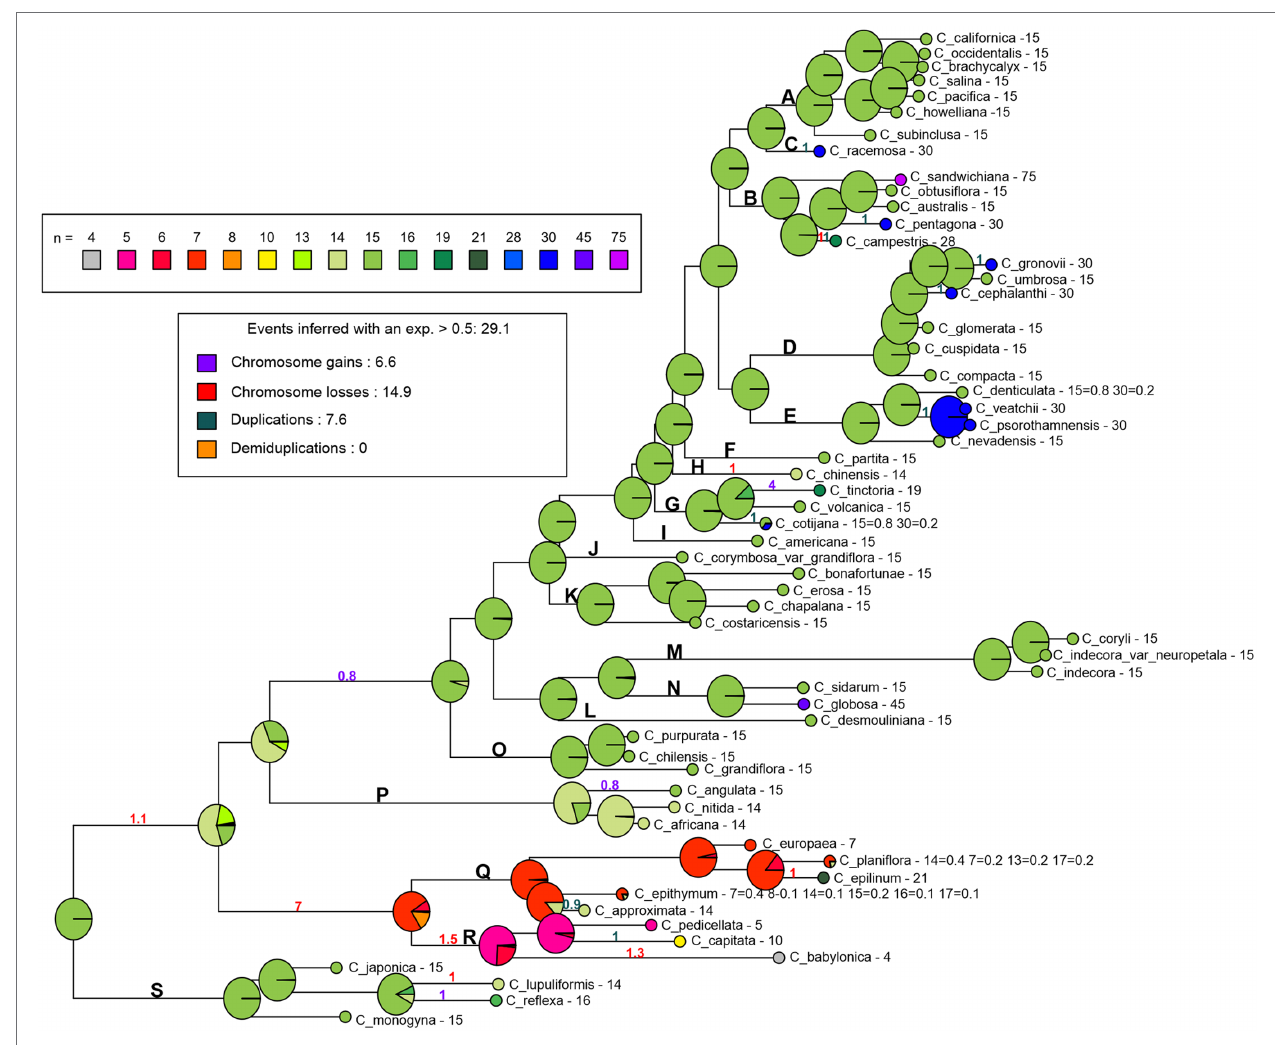
FIGURE 4 | Reconstruction of the chromosome number evolution in Cuscuta with the BASE_NUM_DUPL model and the number n = 15 fixed in the base. The pie charts at nodes represent the probability of each inferred chromosome number, the numbers along the branches represent the probability of frequencies of the inferred events (gains, losses, duplications, and demiduplications). The bold letters represent the sections described by García et al. (2014): section S (subgenus Monogynella ), sections R and Q (subgenus Cuscuta ), section P (subgenus Pachystigma ), and sections A–O (subgenus Grammica